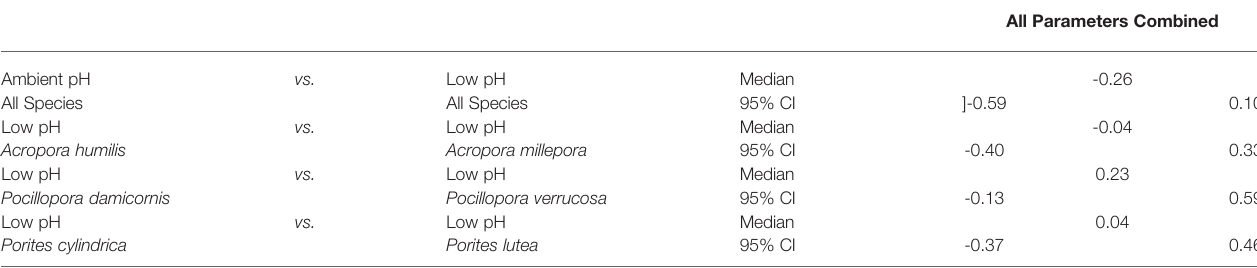
All Parameters Combined